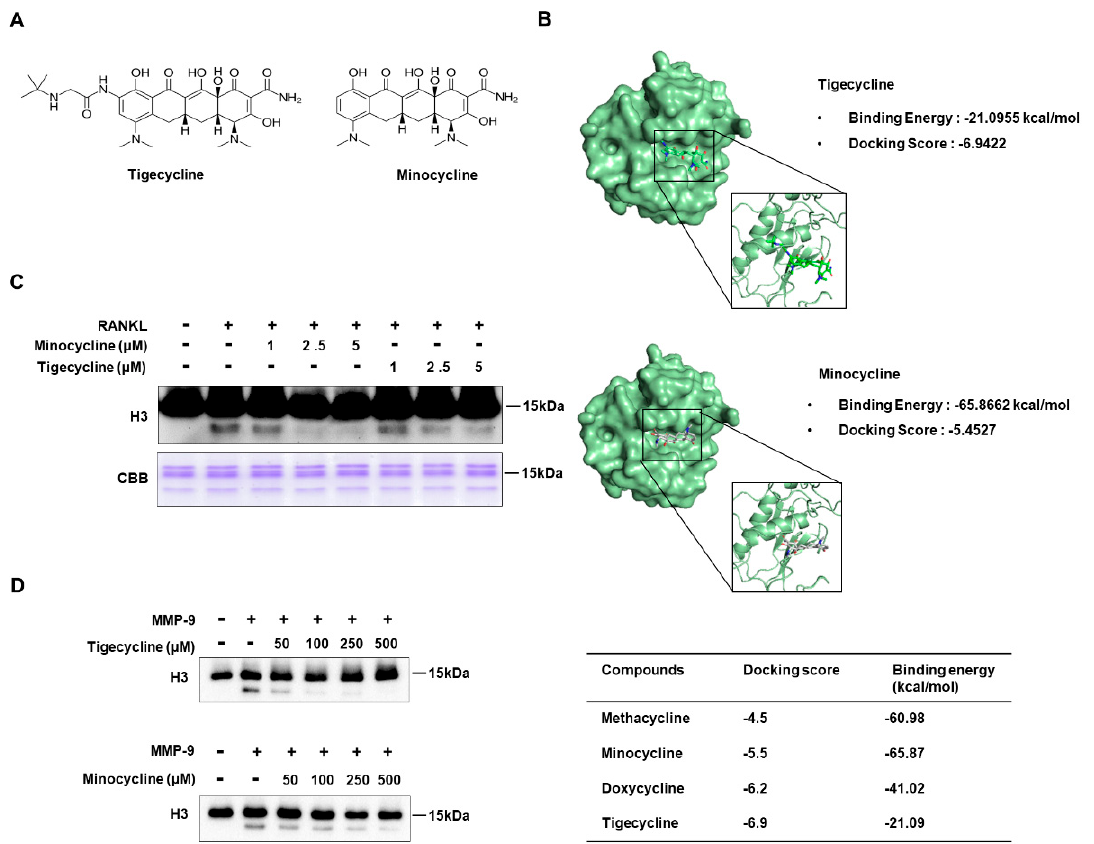
Figure 1. Tigecycline and minocycline inhibit histone H3 tail cleavage by matrix metalloproteinase-9 (MMP-9). ( A ) Chemical structures of tigecycline and minocycline. ( B ) Molecular docking analysis of MMP-9 and tetracycline derivatives. ( C ) Bone marrow-derived macrophages (BMMs) were treated with macrophage colony-stimulating factor (M-CSF) and receptor activator of nuclear factor kappaB ligand (RANKL) in the absence or the presence of tigecycline or minocycline for three days. Chromatin fractions were prepared and subject to Western blot analysis using an anti-H3 antibody (upper panel) and Coomassie brilliant blue staining (lower panel). ( D ) Inhibitory e ff ects of tigecycline and minocycline on MMP-9-mediated H3 tail cleavage. An in vitro H3NT cleavage assay was performed using recombinant histone H3 and MMP-9, pre-incubated with or without tigecycline or minocycline at the indicated concentrations. The extent of H3 tail proteolysis was evaluated by Western blotting with the H3